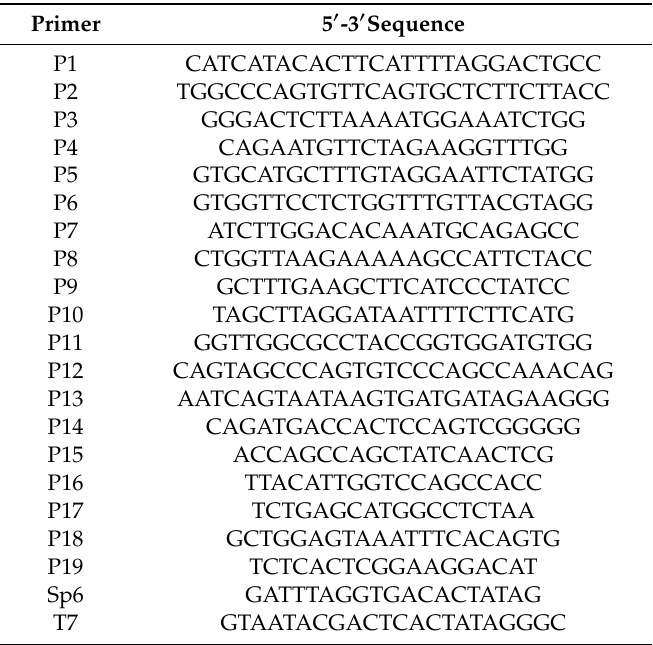
Table 3. List of additional primers used in this